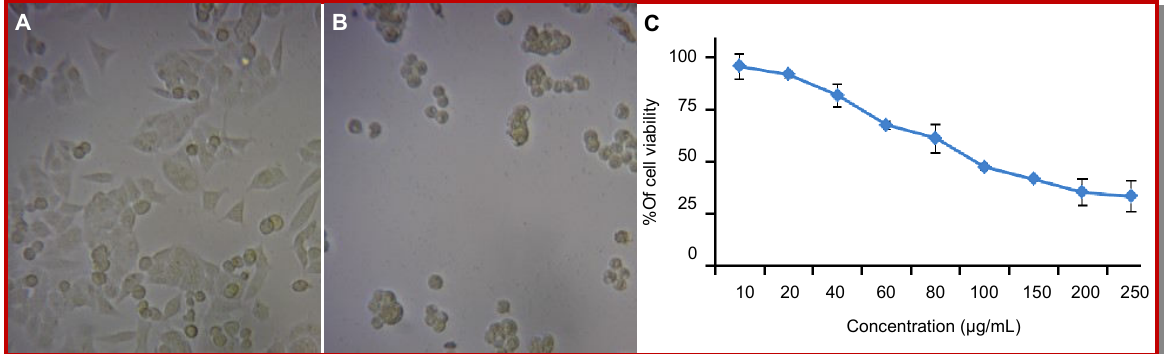
Figure 1: Photomicrographs of the control (A), Z. decandra (100 µg/mL)-treated cells (B) and cytotoxicity of Z. decandra on HCT-116